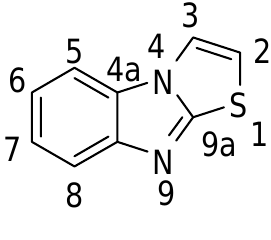
Figure 2. Chemical Abstract numbering of thiazolo[3,2- a ]benzimidazole